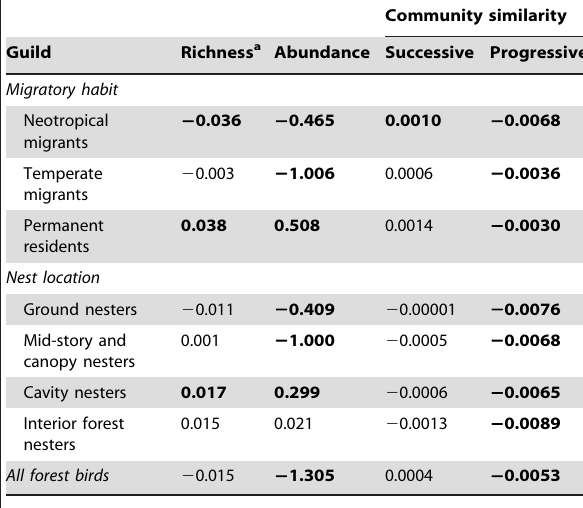
Table 1. Mean annual trends in forest bird community structure over time for 122 Breeding Bird Survey routes located in the forested ecoregions of the conterminous United States,